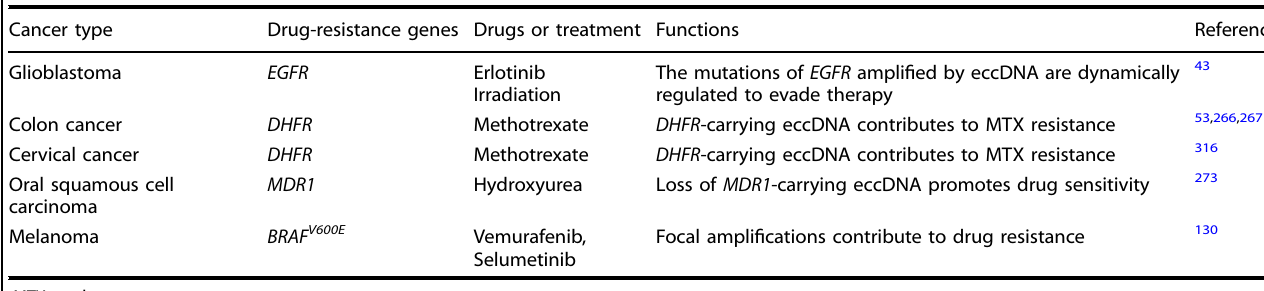
Table 3. Summary of eccDNA-related drug resistance Cancer